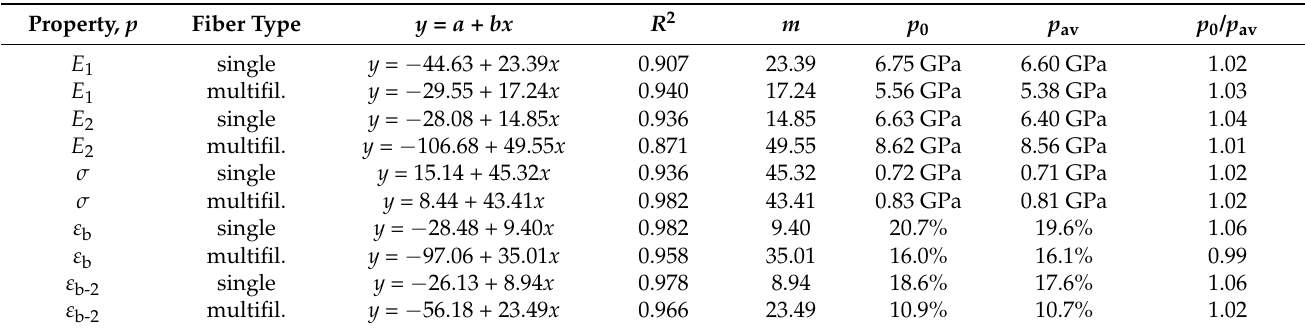
Table 2. Results of Weibull’s distribution analysis of various mechanical properties ( p ) of single and multifilament fibers of PA